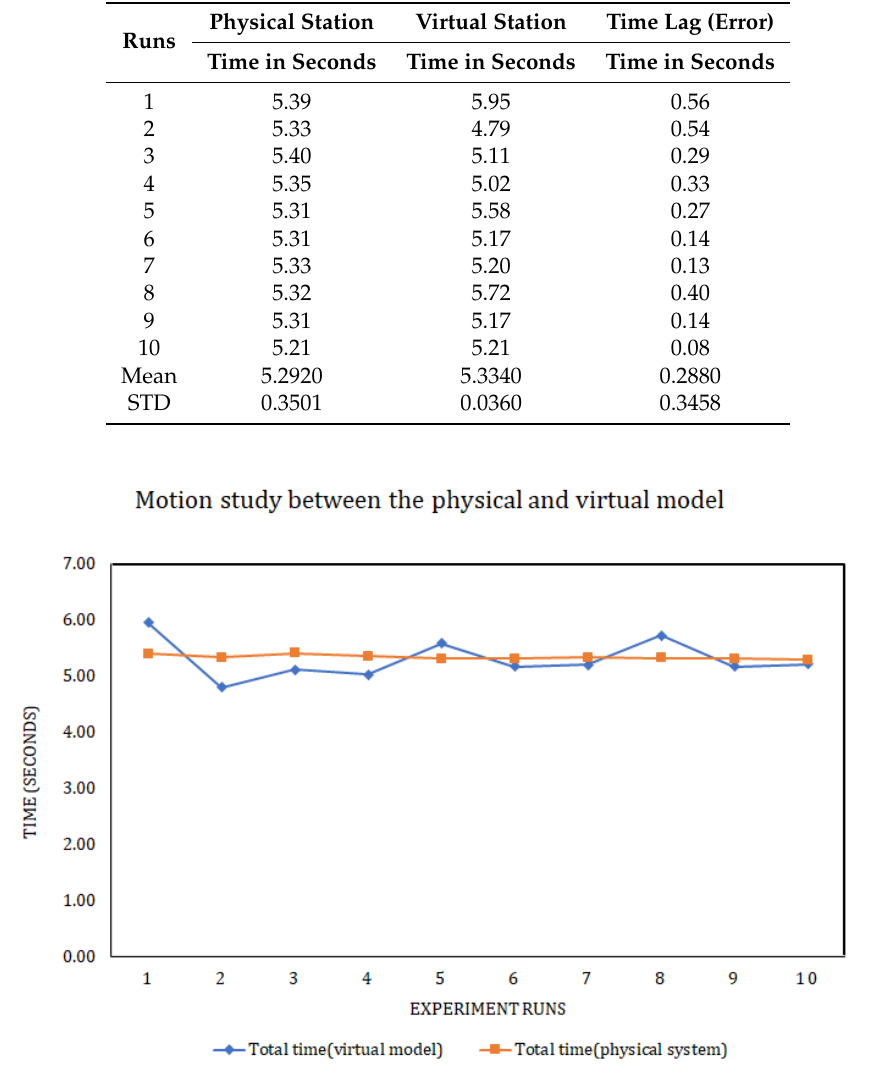
Figure 16. Graph illustrating the run times for the digital twin and physical system for 10 test